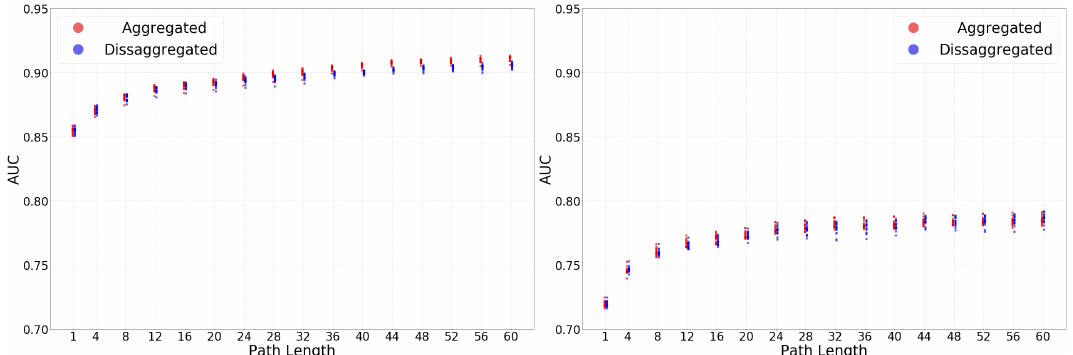
Figure 7. Comparison of the accuracy in the linear model for aggregated frequency against disaggregated frequency. On the left side we have the campaign granularity and on the right the channel granularity. Preferably see it in